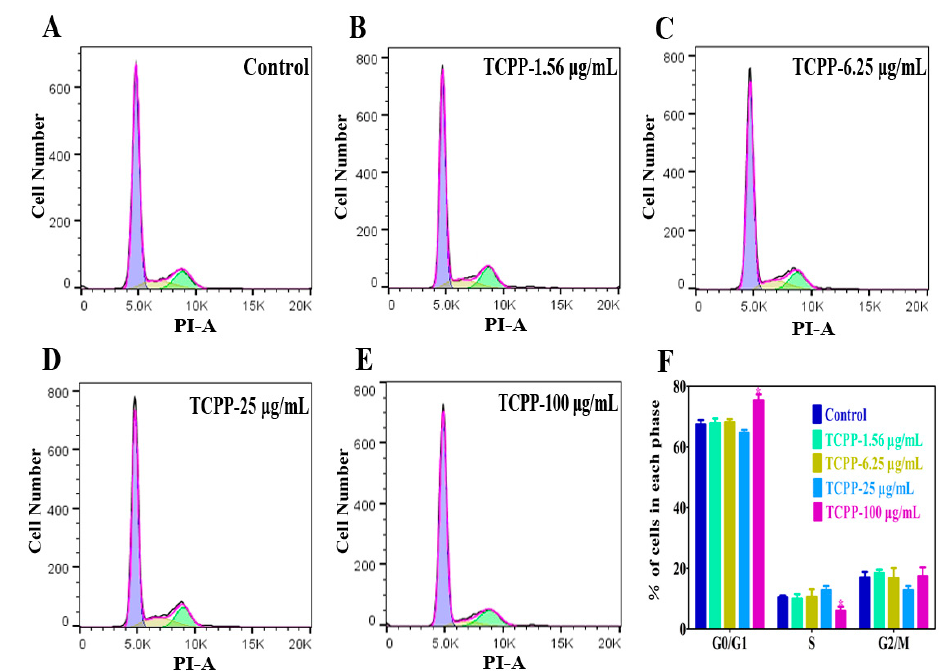
Figure 5. Cell cycle arrest was measured by flow cytometry after exposure to 1.56–100 µ g/mL TCPP for 24 h ( A – E ) and the change of cell population induced by TCPP ( F ). TCPP caused a marked G0/G1 cell cycle arrest, evidenced by a higher number of cells residing in the G0/G1 phase and reducing S phase entry, especially at 100 μ g/mL (* p < 0.05).